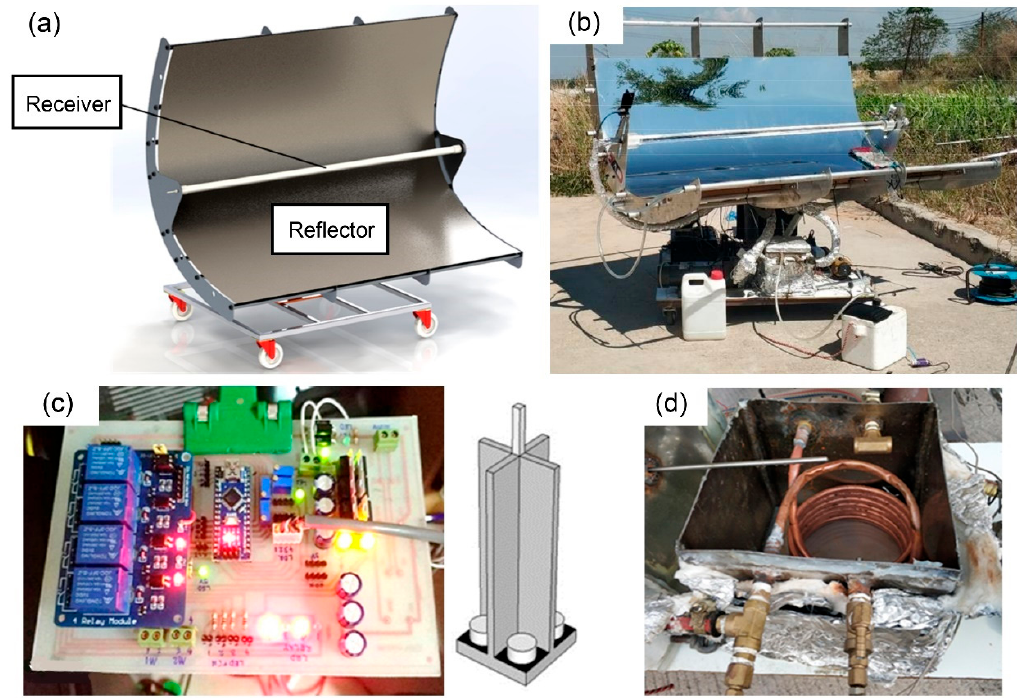
Figure 1. Various view of vacuum-tube parabolic solar collector: ( a ) perspective view from using SolidWorks, ( b ) photographic view after setup, ( c ) solar tracking controller module, and ( d ) heat exchanger.